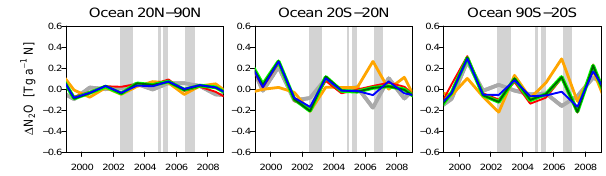
Fig. 8. Ocean region flux anomalies (units of Tga − 1 N). The grey- shaded areas indicate El Niño events (MEI ≥ 0.6). (Legend the same as in Fig. 7.)